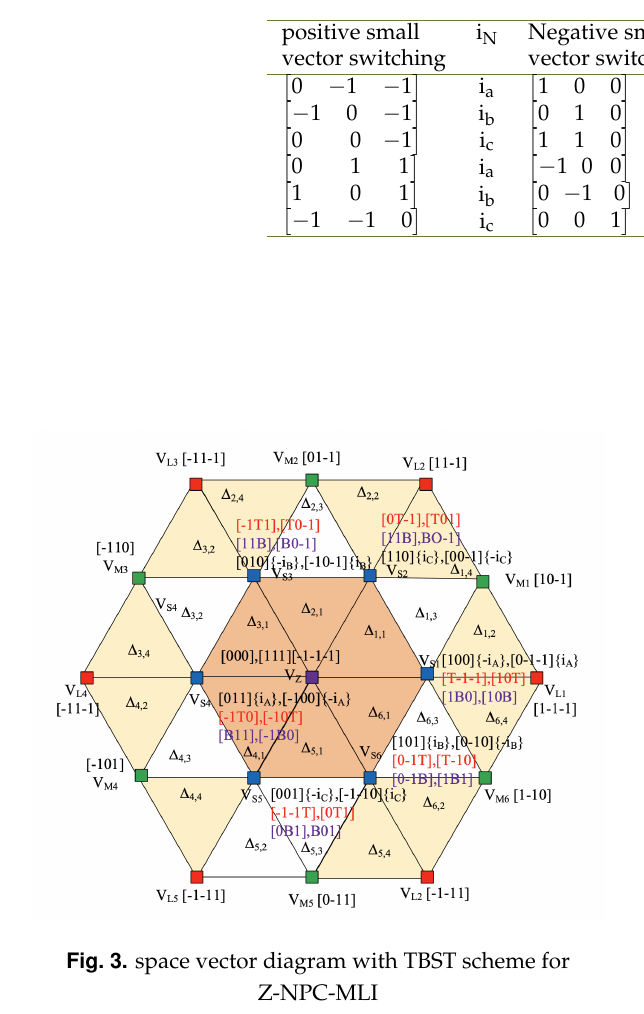
Fig. 2. Z-source MLI with different active switching states with their phase current Table 2. Neutral point and phase currents relation for different switching states